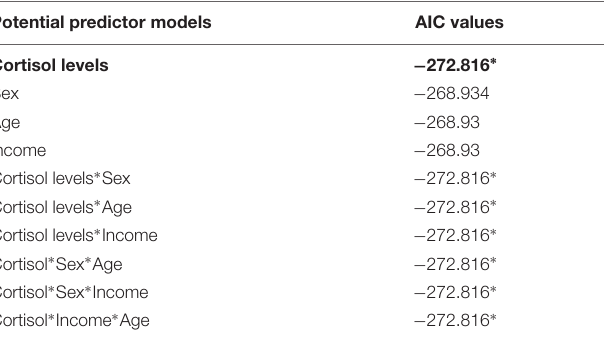
Potential predictor